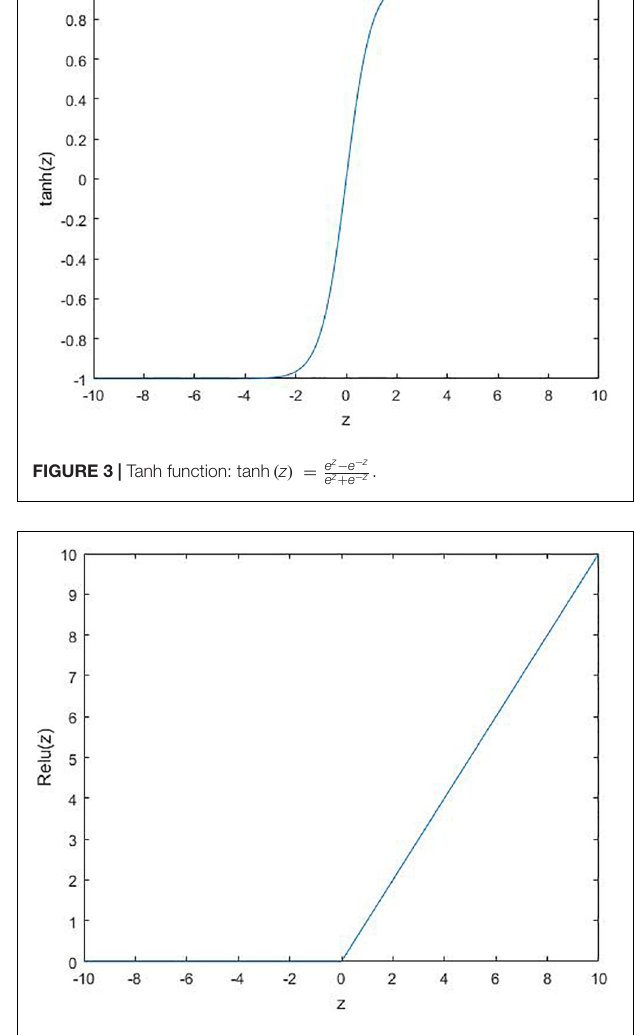
FIGURE 4 | Relu function: relu ( z ) = max ( 0 , z )